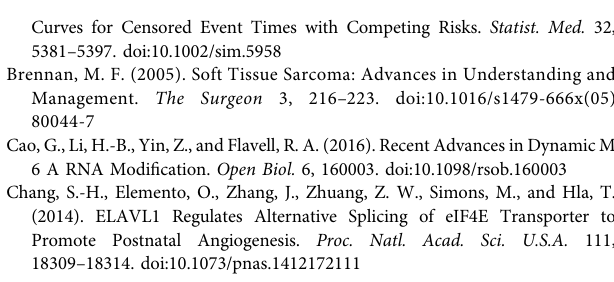
Supplementary Figure S2 | The expression of 25 m6A regulators between HSMC and A673 cells; (A – Y) the expression of different m6A regulators between HSMC and A673 cells. p < 0.05*, p < 0.01**, p < 0.001***, and p = 0****. SupplementaryFigureS3| Thecumulativedistributionfunctionplotanddeltaarea plot for clustering in TCGA-SARC. (A) The cumulative distribution function plot in TCGA-SARC; (B) the delta area plot for clustering in TCGA-SARC. Supplementary Figure S4 | Exploration of differences in the microenvironment between different m6A modi fi cation patterns and normal tissue in GSE17674. (A) TheresultofconsensusclusteringanalysisinGSE17674; (B) comparisonofimmune score between m6A cluster A and normal tissue in GSE17674; and (C) comparison of immune score between m6A cluster B and normal tissue in GSE17674. SupplementaryFigureS5| Thecumulativedistributionfunctionplotanddeltaarea plot for clustering in TCGA-SARC based on 328 DEGs. (A) The cumulative distribution function plot in TCGA-SARC based on 328 DEGs; (B) the delta area plot for clustering in TCGA-SARC based on 328 DEGs. Supplementary Figure S6 | The ROC curve of m6A score for prediction of the 1-, 3-, and 5-years survival of STS in TCGA-SARC. Supplementary Figure S7 | The event-free survivalplot of high and low m6A score in the GSE17618 dataset (p =